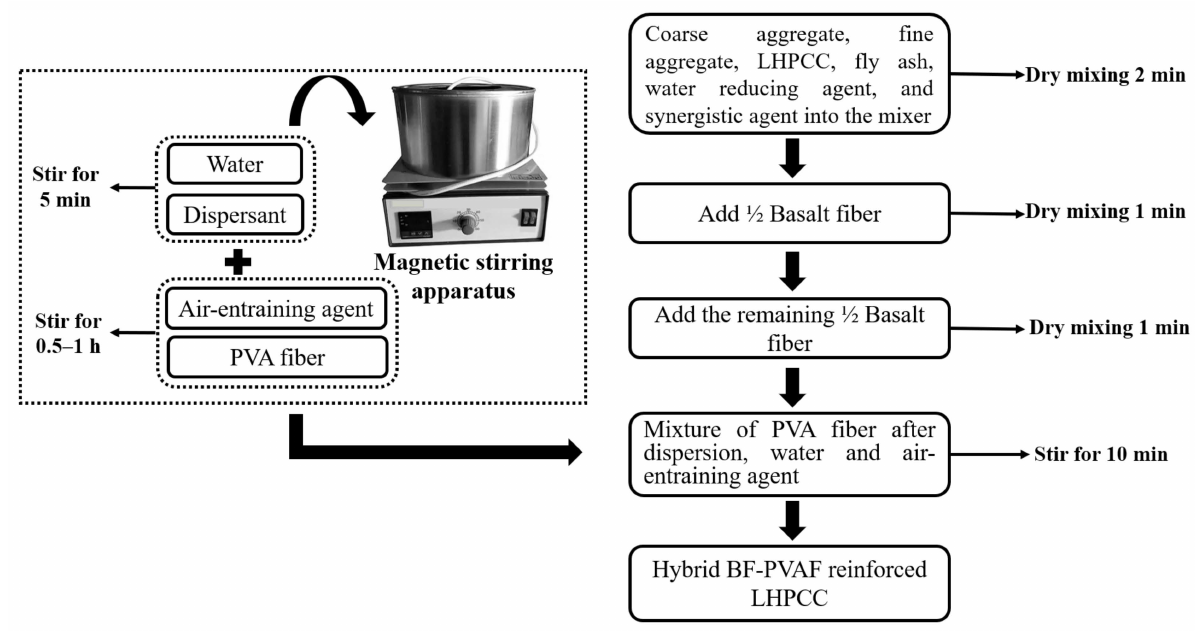
Figure 2. Fabrication process of hybrid BF-PVAF-reinforced